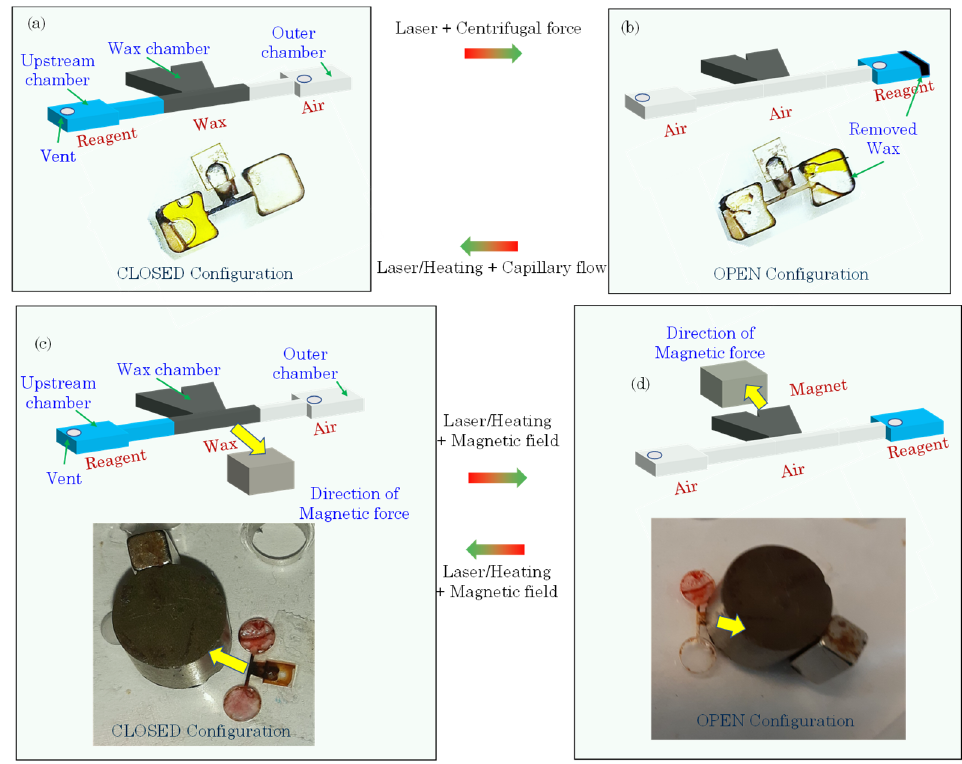
Figure 1. ( a ) Normally closed configuration of the capillary wax valve. It can be switched to open mode by melting the wax plug blocking the channel (using a laser) and spinning the disc to flow the molten wax plug downstream, clearing the channel to open the fluidic channel. ( b ) The switch from normally open to closed configuration is achieved by melting the ferrowax in the wax chamber using a laser. Under the action of the capillary force, the molten wax flows into the valving channel and seals it, thus switching the valve from normally open to closed configuration. With enough wax in the wax chamber, this process is repeatable. ( c ) Normally closed configuration of the magnetic wax valve. It can be switched to open by melting the wax plug blocking the channel and the wax reservoir (laser/heating) and moving the wax with the magnet out of the channel, clearing the channel and opening the valve from normally closed to open configuration. ( d ) The switch from normally open to closed configuration (magnet wax valve) is achieved by melting the ferrowax in the wax chamber (using laser) and moving the wax with the magnet into the channel. This reversibly changes the configuration from normally open to closed configuration. Yellow arrows show the direction of the magnetic force.